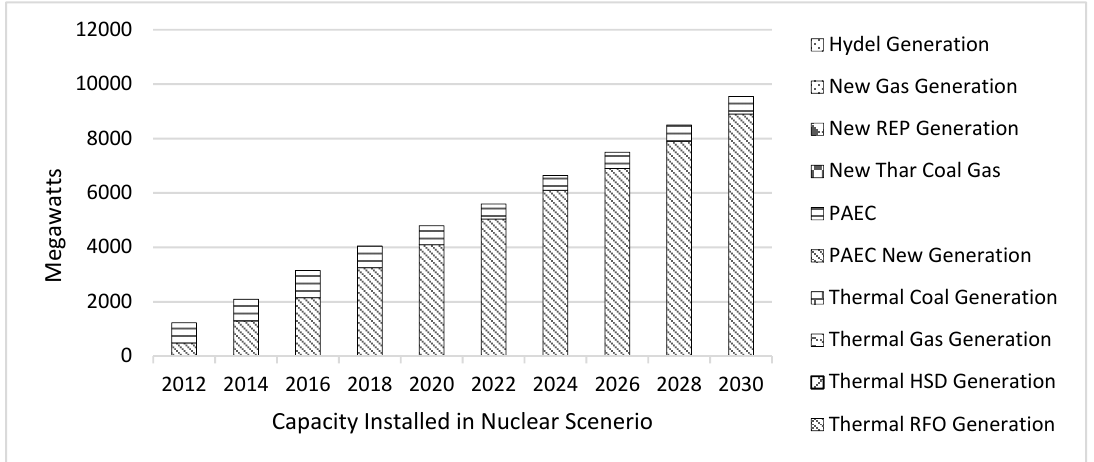
Figure 11. Nuclear scenario of installed capacities.